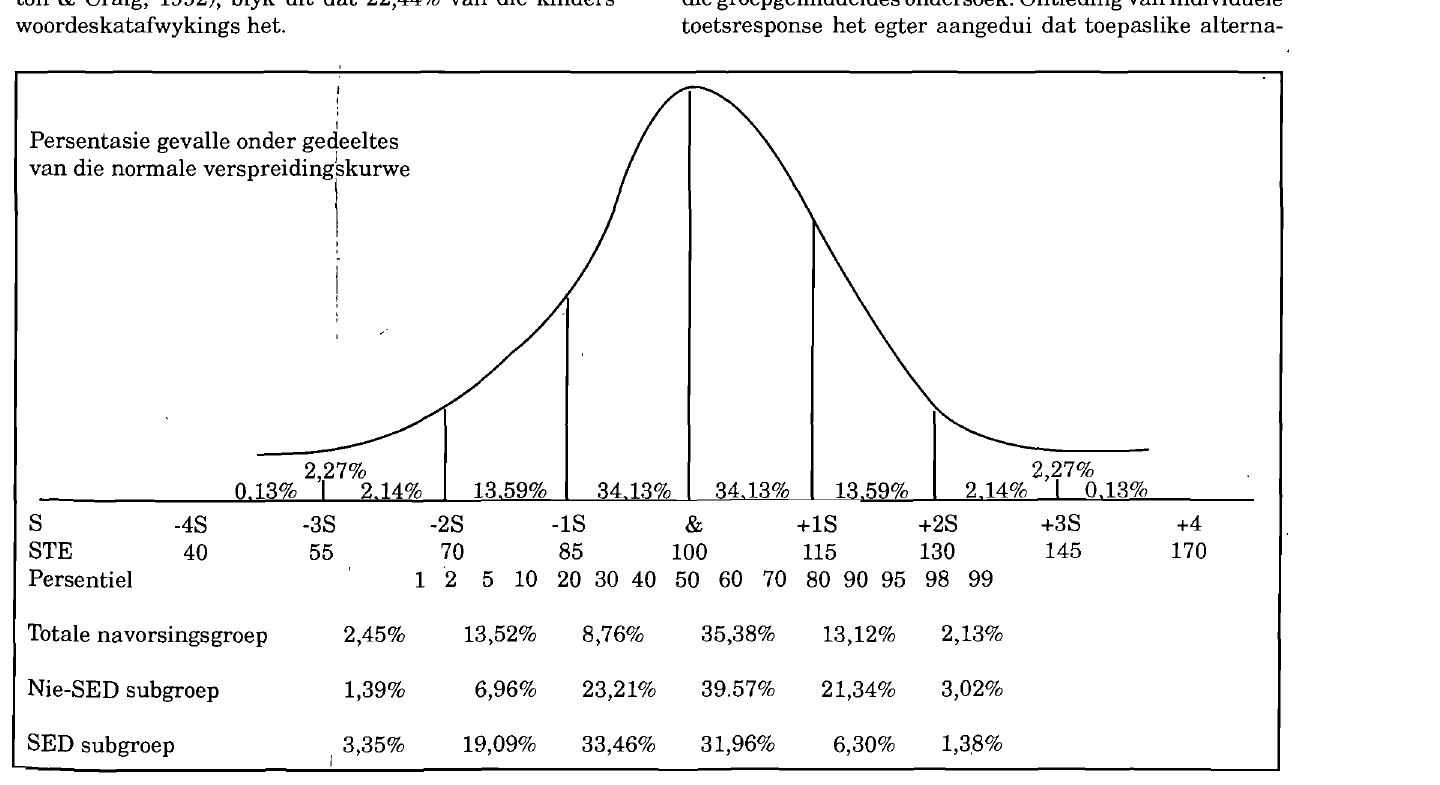
FIGUUR 3: Standaardtellingekwivalentverspreiding op die normale verspreidingskurwe Die Suid-Afrikaanse Tydskrifuir Kommunikasieafwykings, Vol. 45,